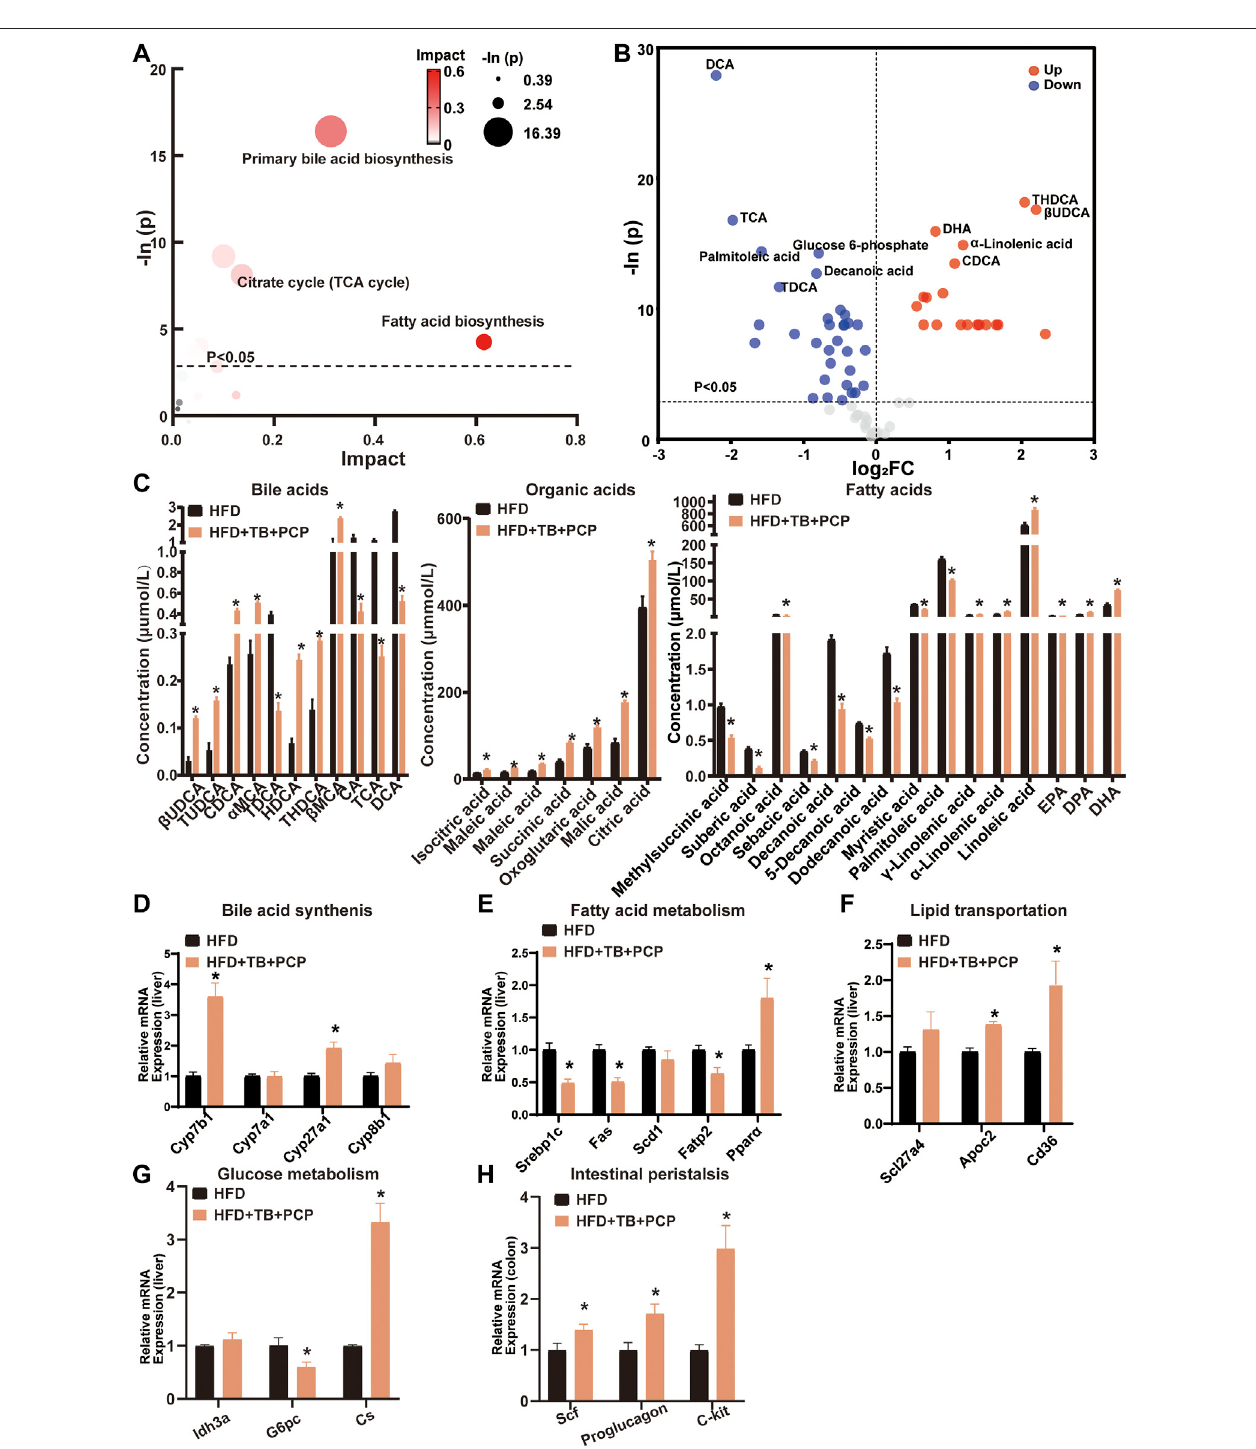
FIGURE5|(A) Bubblechartofpotentialsignalingpathways.PathwayanalysiswasperformedintheKEGGdatabase.Thecolorandsizeofeachbubblerepresent theimpactofmetabolitesineach pathwayand p value,respectively. (B) Volcanoplotforthedifferentialmetabolites(HFD+TB+PCP groupvs.HFDgroup). Metabolites withstatisticallysigni fi cantdifferentiallevelslieaboveahorizontalthresholdline.Metaboliteswithlargefoldchangevaluesliefarfromtheverticalthresholdlineatlog2-fold change=0,indicatingwhetherthemetaboliteisupordownregulated. (C) Theconcentrationofdifferentialserummetabolites. (D) ThemRNAexpressionofhepatic BA synthetic genes. (E) The mRNA expression of fatty acid metabolism-related genes. (F) The mRNA expression of hepatic lipid transportation genes. (G) mRNA expression of TCA cycle-related genes. (H) The mRNA expression of intestinal peristalsis-related genes. n = 8 individuals/group. Data were expressed as mean ± SEM. Differences between data were assessed by the Mann – Whitney U test; * p < 0.05 compared with the HFD group.